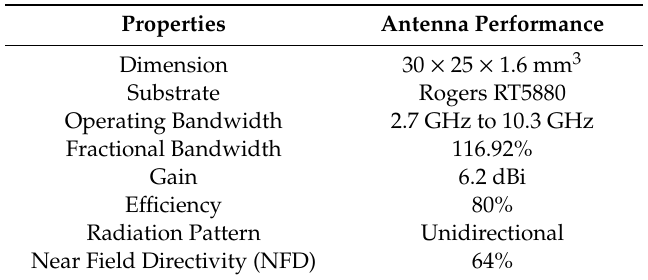
Figure 8. 2D and 3D radiation pattern of the prototype at: ( a ) 5.1 GHz and ( b ) 9.0 GHz. Table 1. Antenna performance summary.